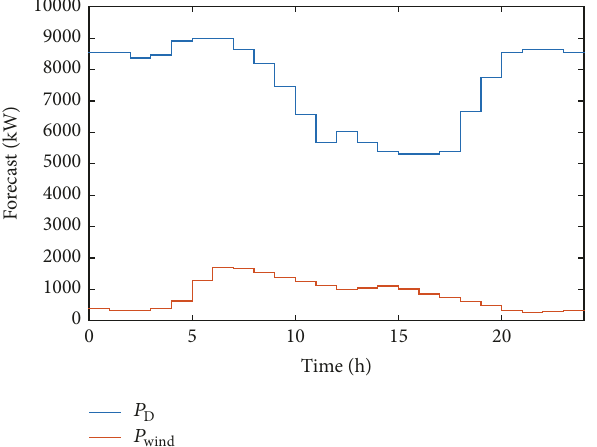
Figure 11: Forecasts of load demand and wind power plant genera- tion for Case Study